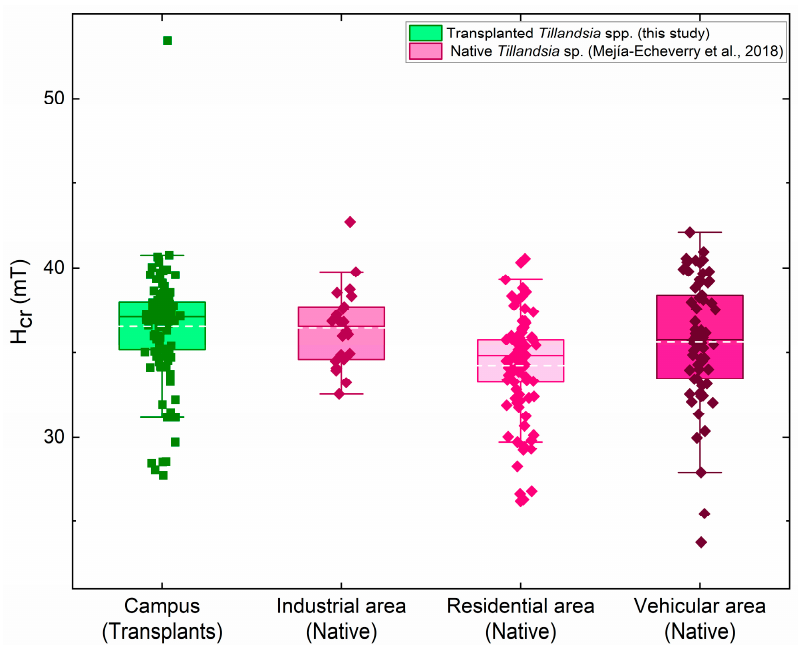
Figure 5. Comparison of H cr between transplanted (Campus, this study) and native Tillandsia spp. [33]. The box delineates the interquartile range of 25–75% (Q1–Q3), and horizontal lines in the box indicate the mean (dash) and median (solid). The minimum and maximum values are shown using whiskers.